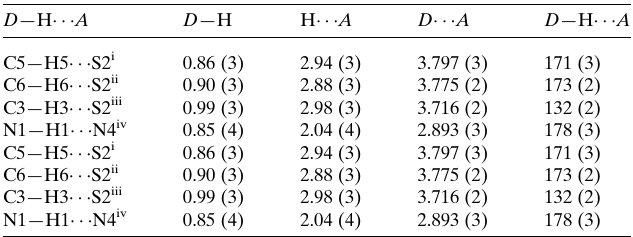
(Table 1). Firstly, N1—H1 (cid:2) (cid:2) (cid:2) N4 hydrogen bonds [C (cid:2) (cid:2) (cid:2) S = 2.893 (2) A˚ ] between neighbouring molecules form a chain.